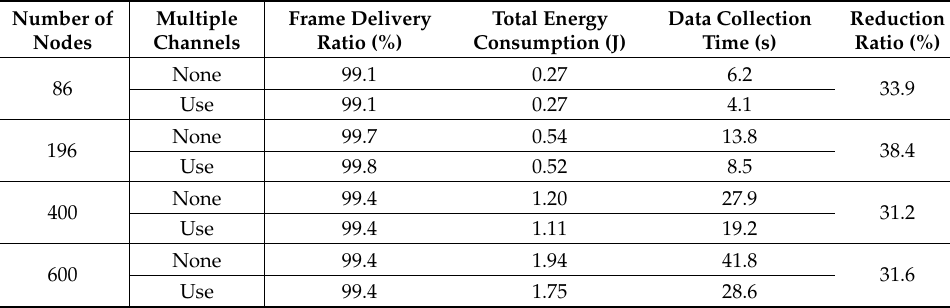
Table 5. Evaluation of using multiple channels.